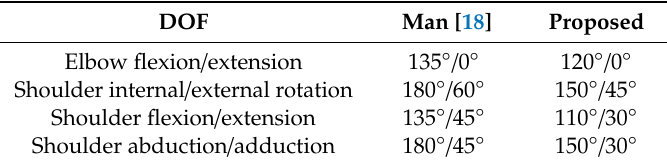
Figure 4. Movement angles as a function of contraction ratio. Table 1. Ranges of motion (ROMs) of four active